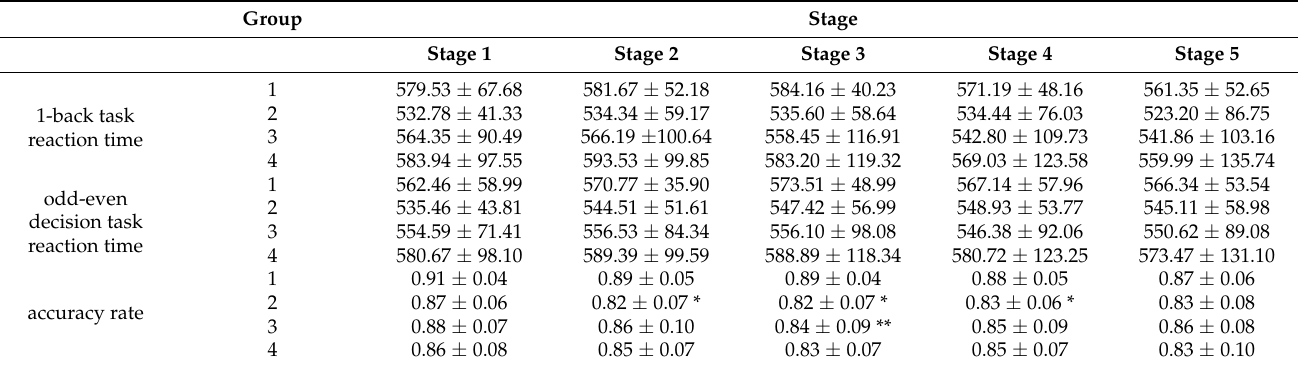
Table 2. TloadDback task results (unit: ms (reaction time); %